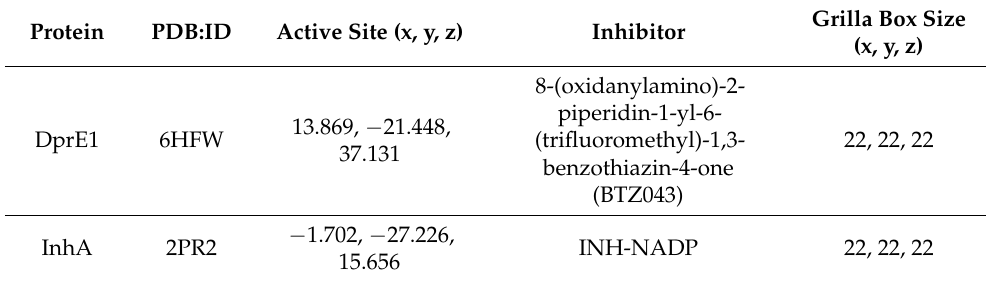
Table 11. Docking